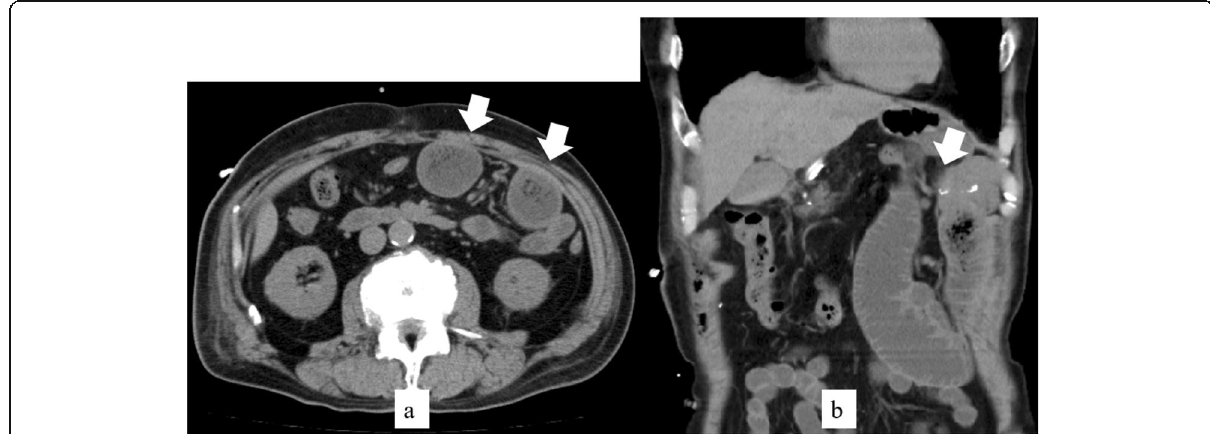
Fig. 1 a , b CT scan imaging of jejunojejunostomy obstruction (imaging of case 3). a Dilation of the elevated jejunum (arrows). b Obstruction of the jejunojejunostomy (arrow)